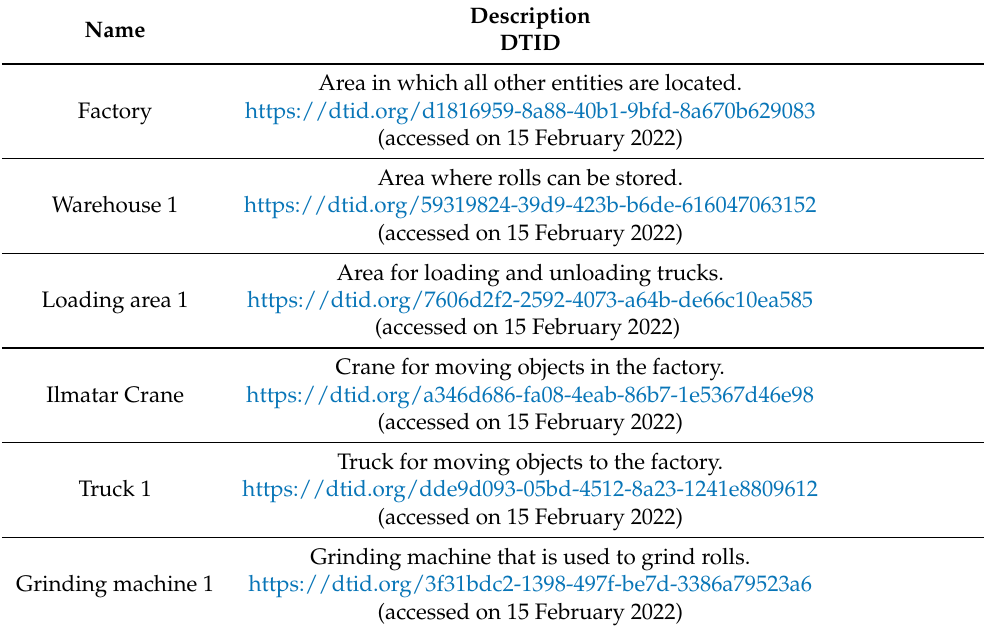
Table 3. List of names and descriptions for entities that have a DT document and links to those DT documents. DT documents used in this paper can be found using their DTIDs, which are URLs, from this table. All DT documents can be read at https://zoelz.github.io/twinbase/ (accessed on 15 February